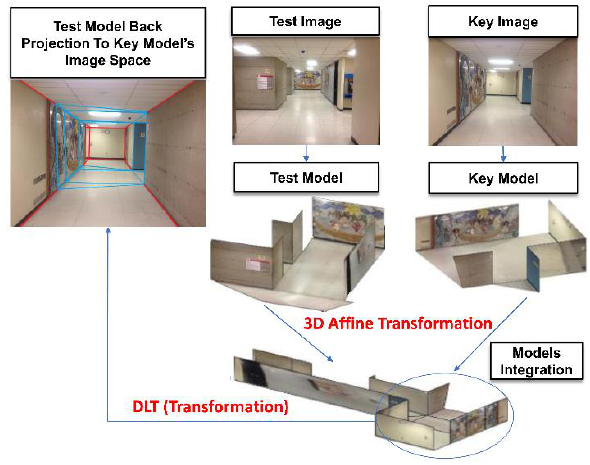
Figure 5. A schematic view of model transformation